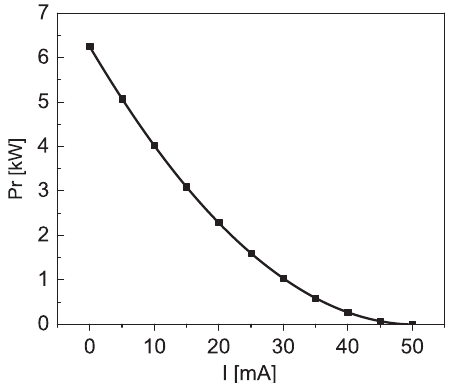
FIG. 31. The two coupler positions relative to the RFQ cavity.